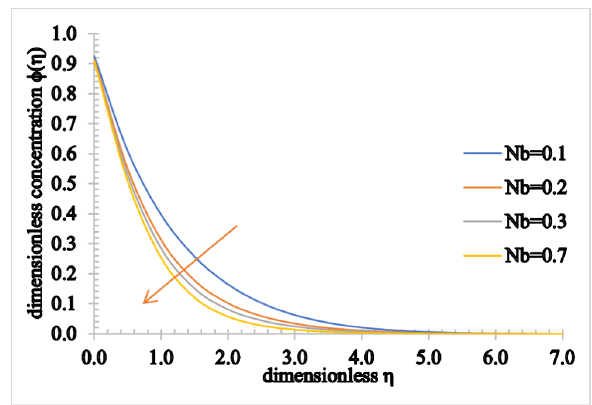
Figure 21: The concentration profile for increasing values of Nb .